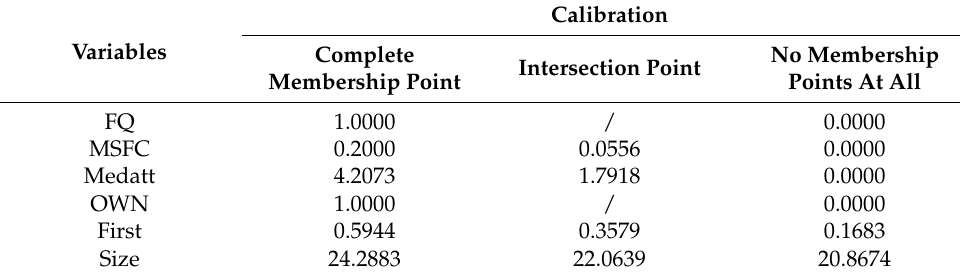
Table 3. Calibration thresholds of outcome and conditions.